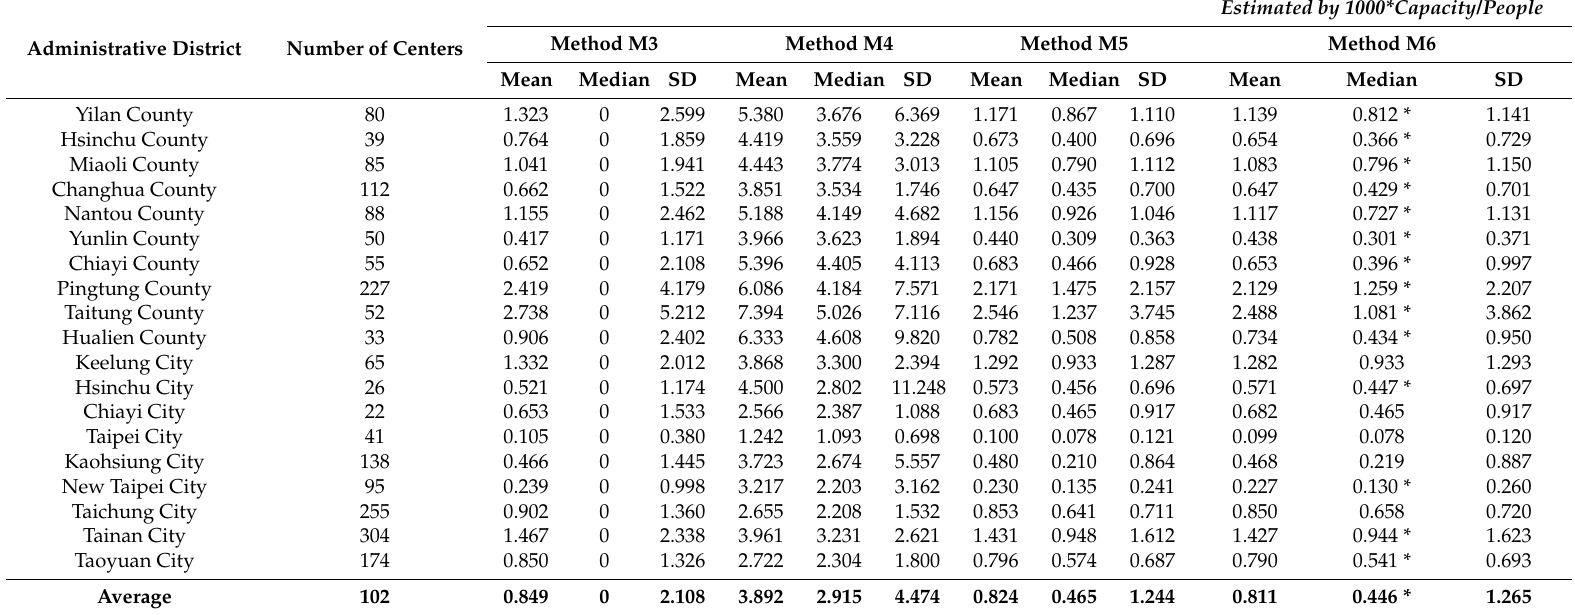
Table 9. Summary statistics of community care resources accessibility measures using methods